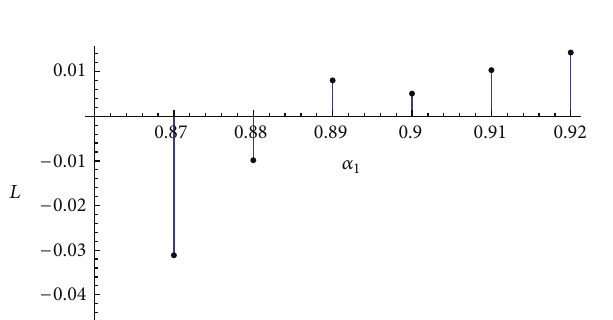
Figure 10: Phase portrait x - z 𝛼 1 = 0.89, 𝛼 2 = 𝛼 3 = 1 .